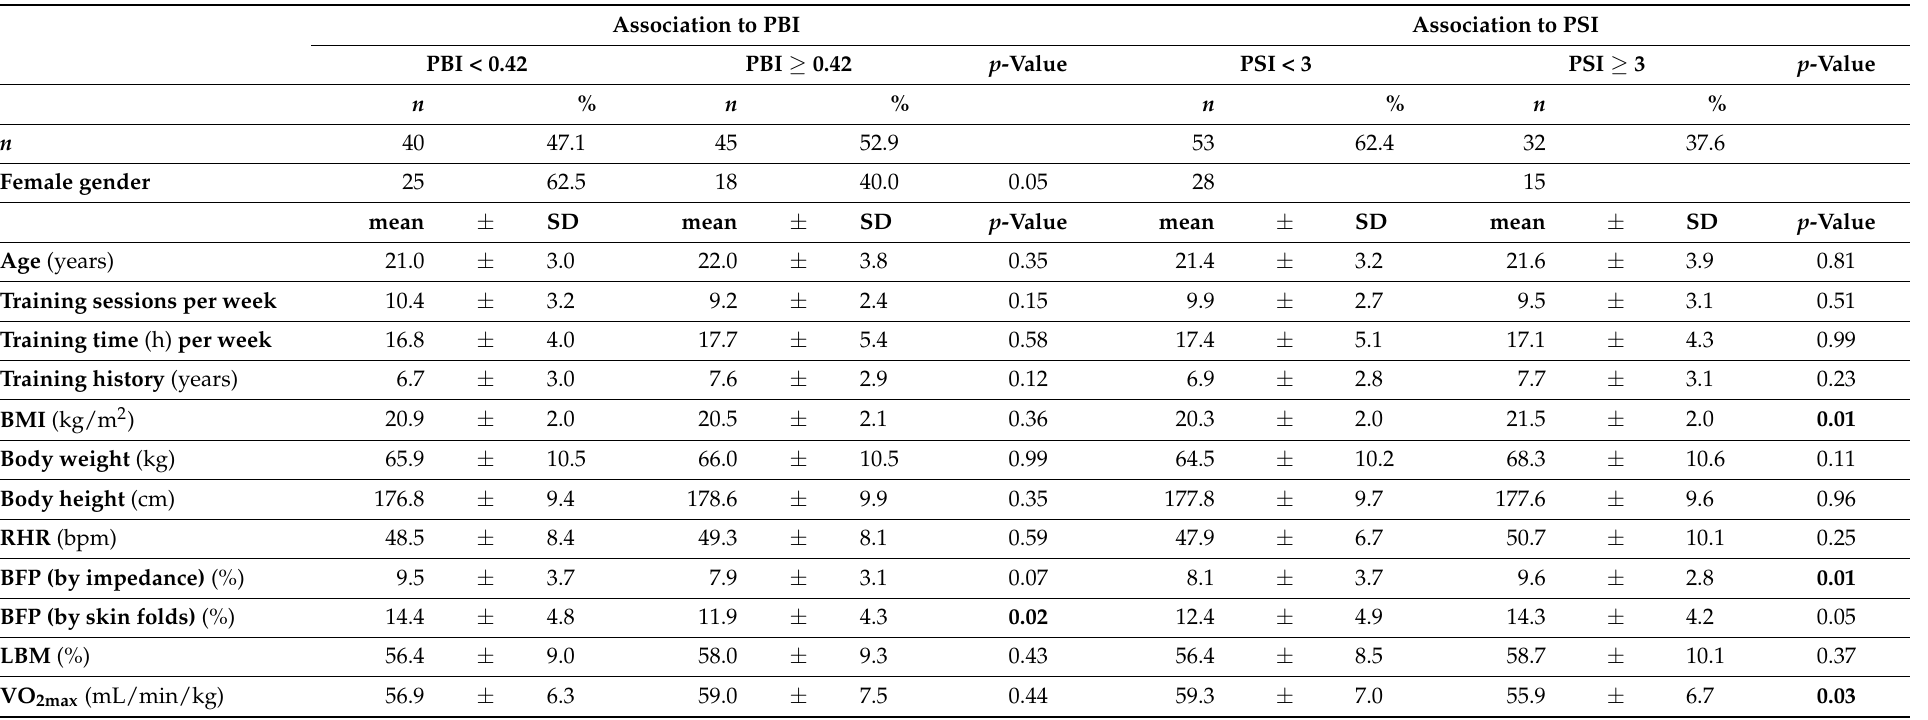
Table 2. Characteristics of the athletes (entire cohort) and their associations with periodontal health (PBI and PSI). Association to PBI Association to